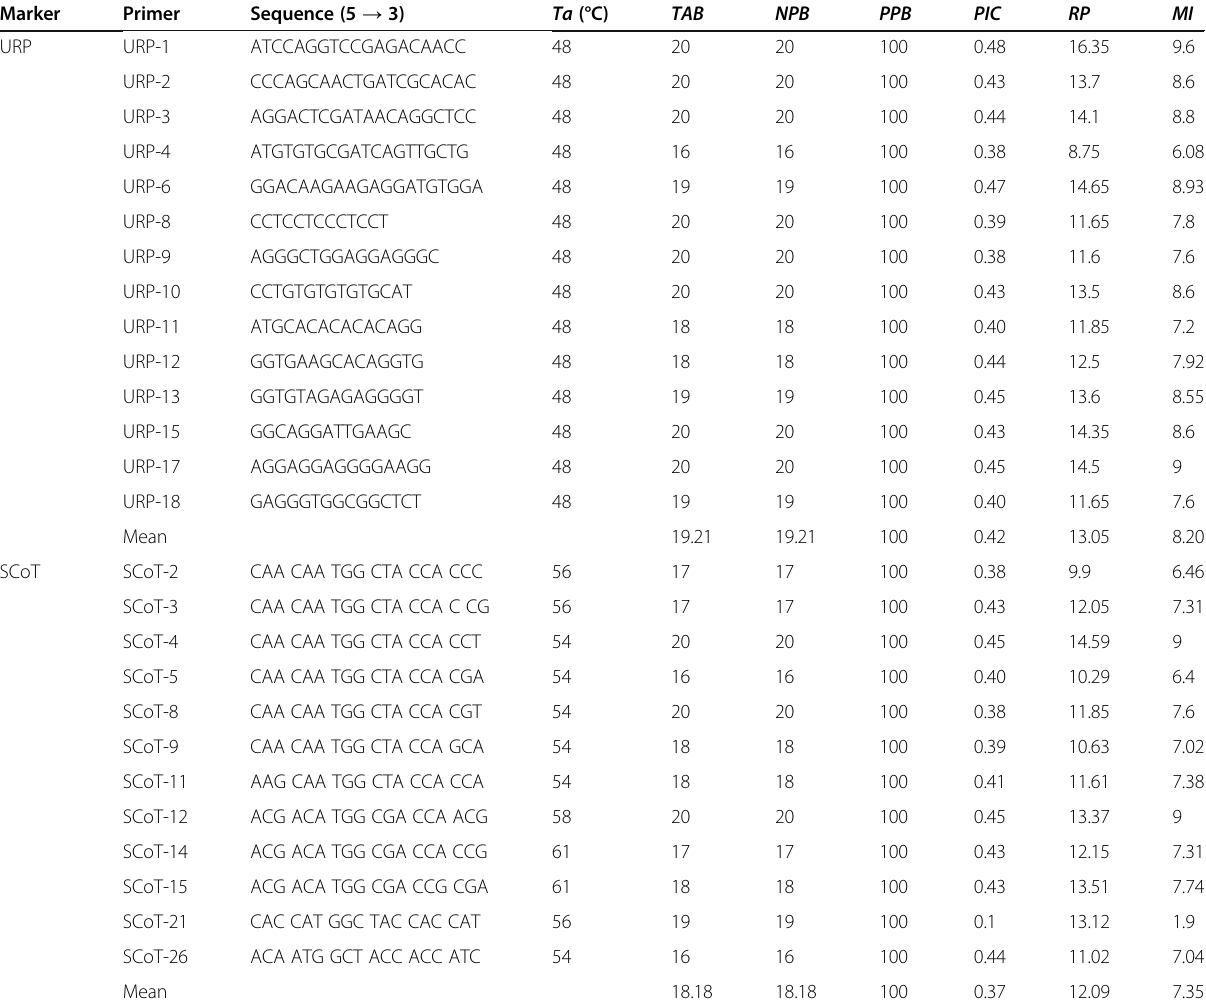
Table 2 URP and SCoT primers and their amplification results generated in the Rosa damascena Mill. germplasm